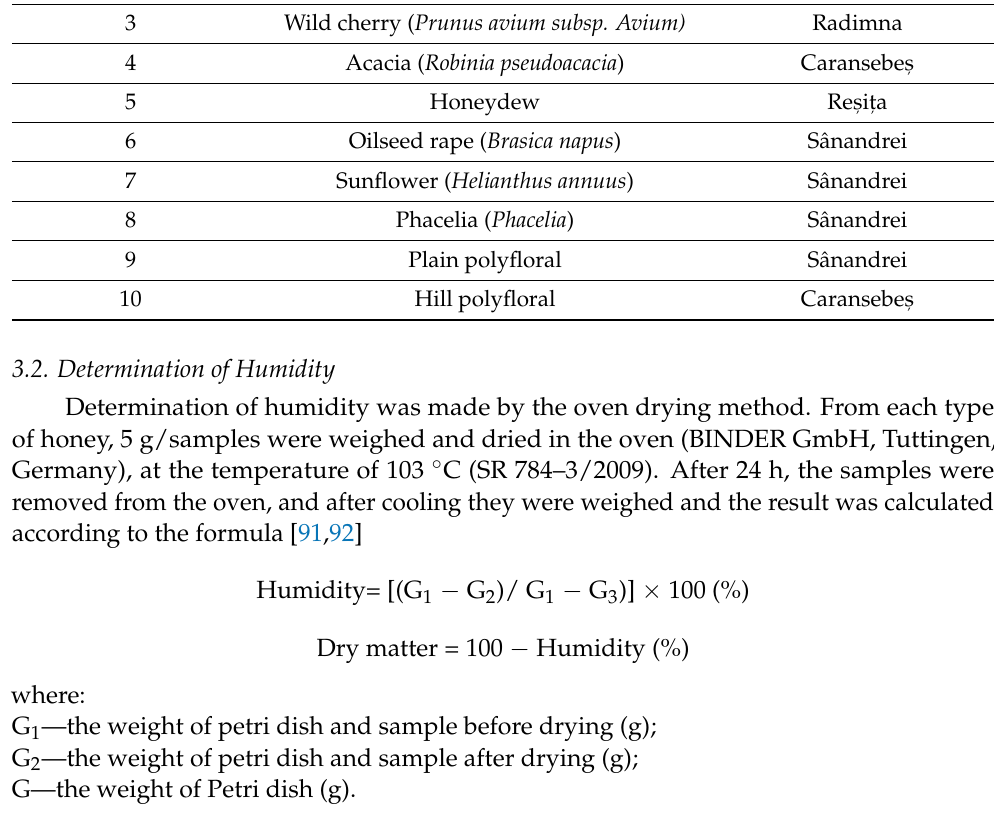
Table 3. The botanical and geographical origin of the honey samples from the region of Banat, Romania. No. Sample Botanical Origin Geographical Origin 1 Knotweed ( Fallopia japonica ) Caransebes 2 Linden ( Tilia europea ) Timis 3 Wild cherry ( Prunus avium subsp. Avium) Radimna 4 Acacia ( Robinia pseudoacacia ) Caransebes 5 Honeydew Res Oilseed rape ( Brasica napus ) S â nandrei Sunflower ( Helianthus annuus ) S â nandrei Phacelia ( Phacelia ) Plain polyfloral S â nandrei Hill polyfloral Caransebes